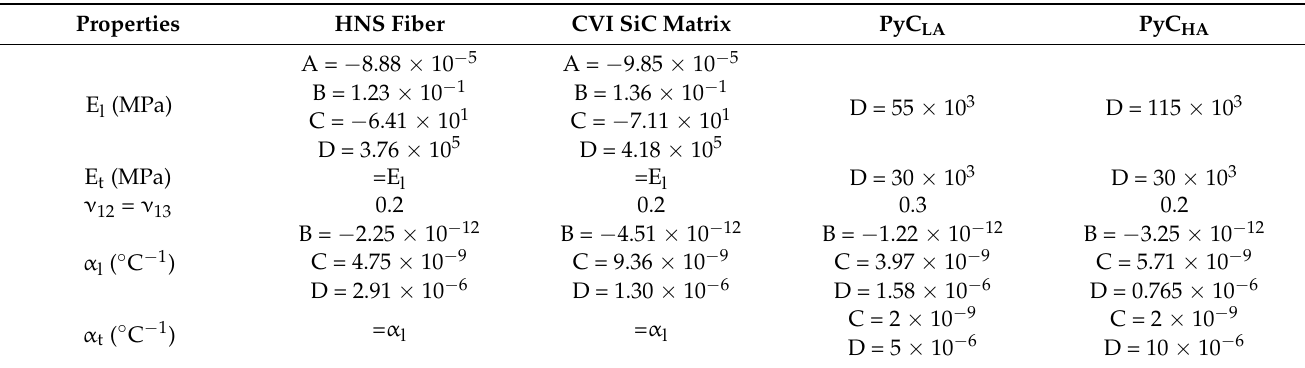
Table 3. Coefficients used in the analytical model for Young’s modulus, Poisson’s ratio and coefficient of thermal expansion (l for longitudinal direction and t for transverse direction).